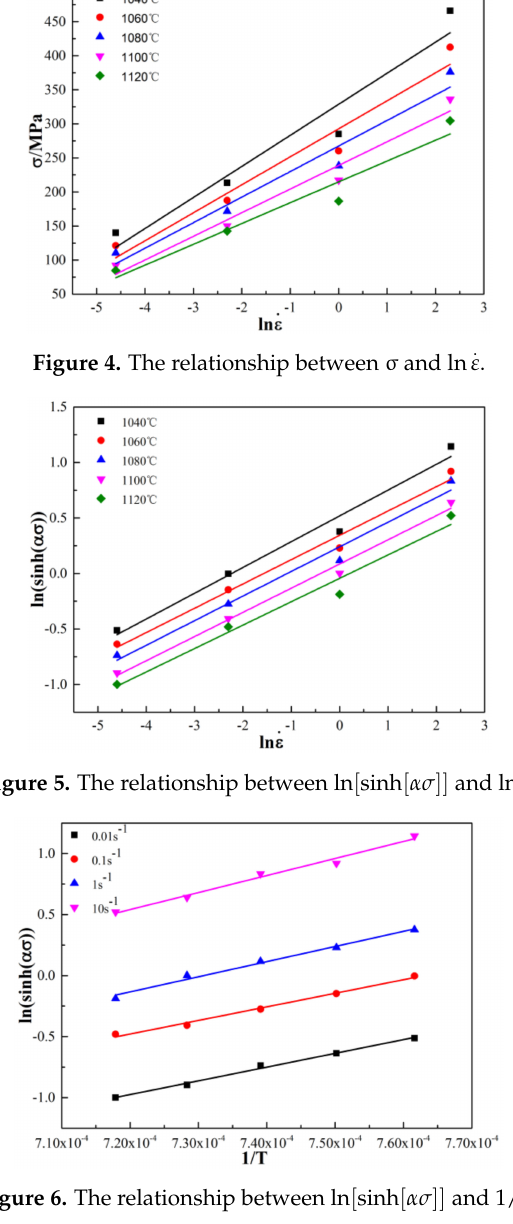
Figure 6. The relationship between ln [ sinh [ ασ ]] and 1/ T